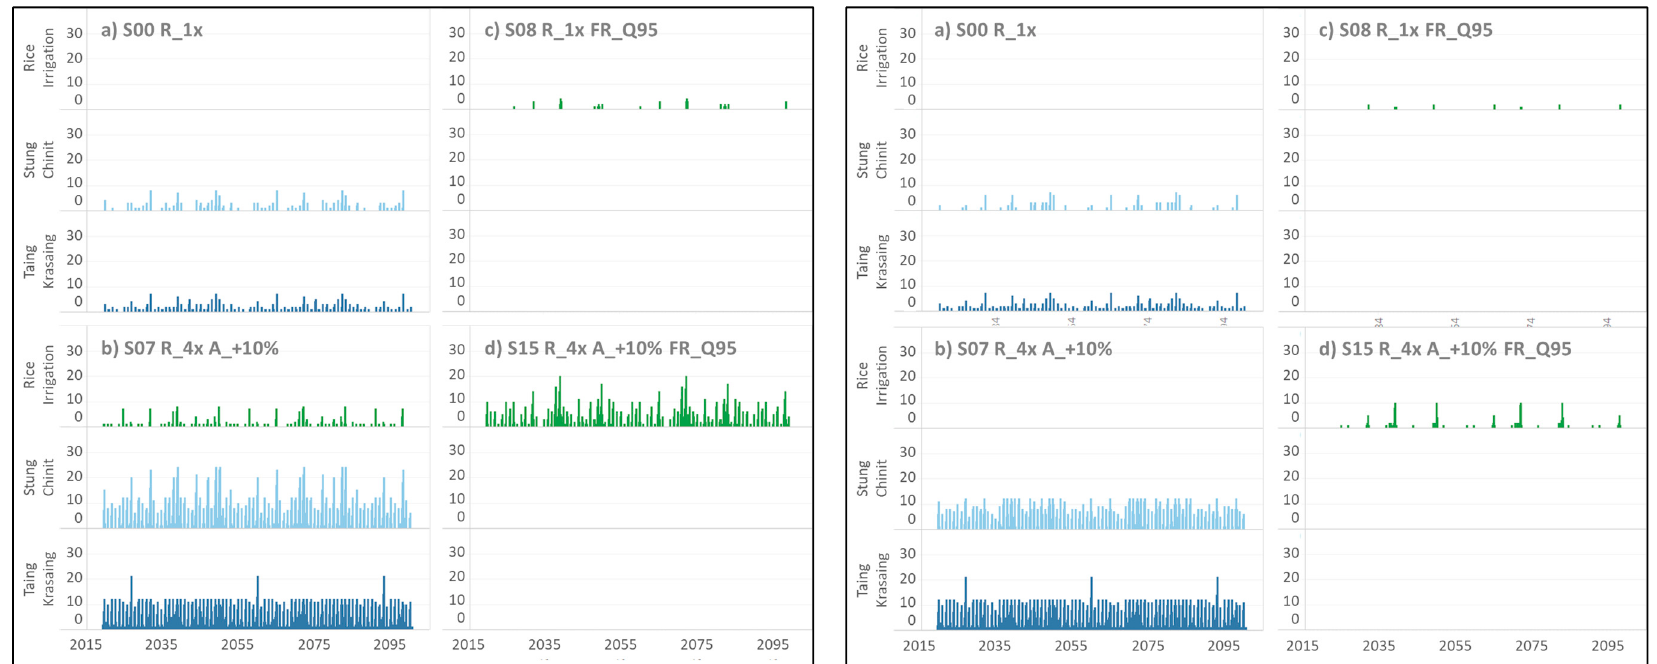
Figure 13. Consecutive weeks of rice and streamflow shortages (defined as a week where coverage is below the coverage criteria). Where each bar exists, a shortage occurred in that week. Where bars are greater than 1, this is the cumulative number of weeks since a shortage did not occur. Strategies S00, S07, S08, S15 are shown, all with historical climate and coverage criteria = 50% ( left ) and 5% ( right ). An interactive graphic with all strategies and climate scenarios can be accessed here: https://public.tableau.com/views/JournalArticleVisualizationStungChinitWatershedCambodia/Story1?:language=en&:display_count=y&publish=yes&:origin=viz_share_link.